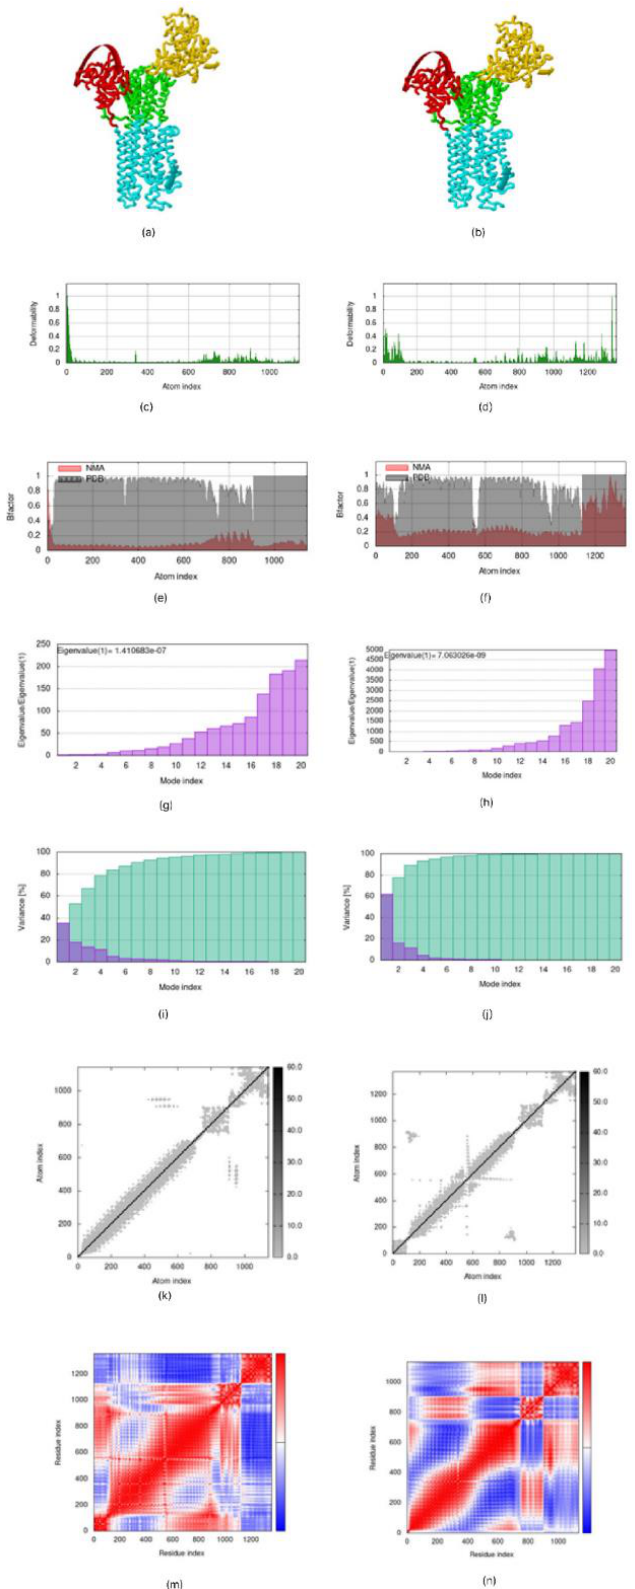
Figure 9. Molecular dynamic simulation results for vaccine-TLR3 and TLR9 complexes showing ( a , b ) spin predictions of the Ligand-Receptor Interaction ( c , d ) deformability ( e , f ) B-factor mobility ( g , h ) NMA mobility eigenvalues ( i , j ) variance ( k , l ) elastic network analysis ( m , n ) covariance matrix.